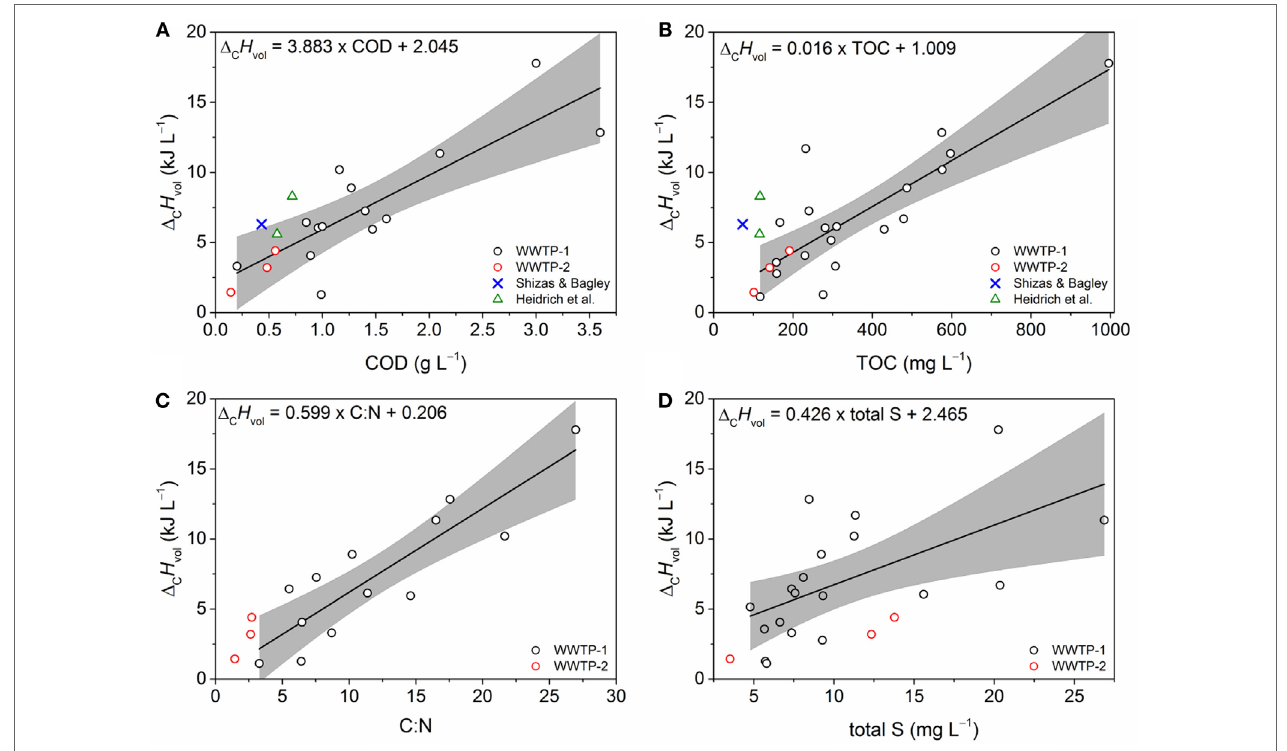
FigUre 2 | Correlation plots of Δ C H vol and wastewater parameters. The plots are based on data from wastewater treatment plant (WWTP)-1 (black circles) and with projected data points from WWTP-2 (red circles), Heidrich et al. (2011) (olive triangles), and Shizas and Bagley (2004) (blue crosses). (a) Chemical